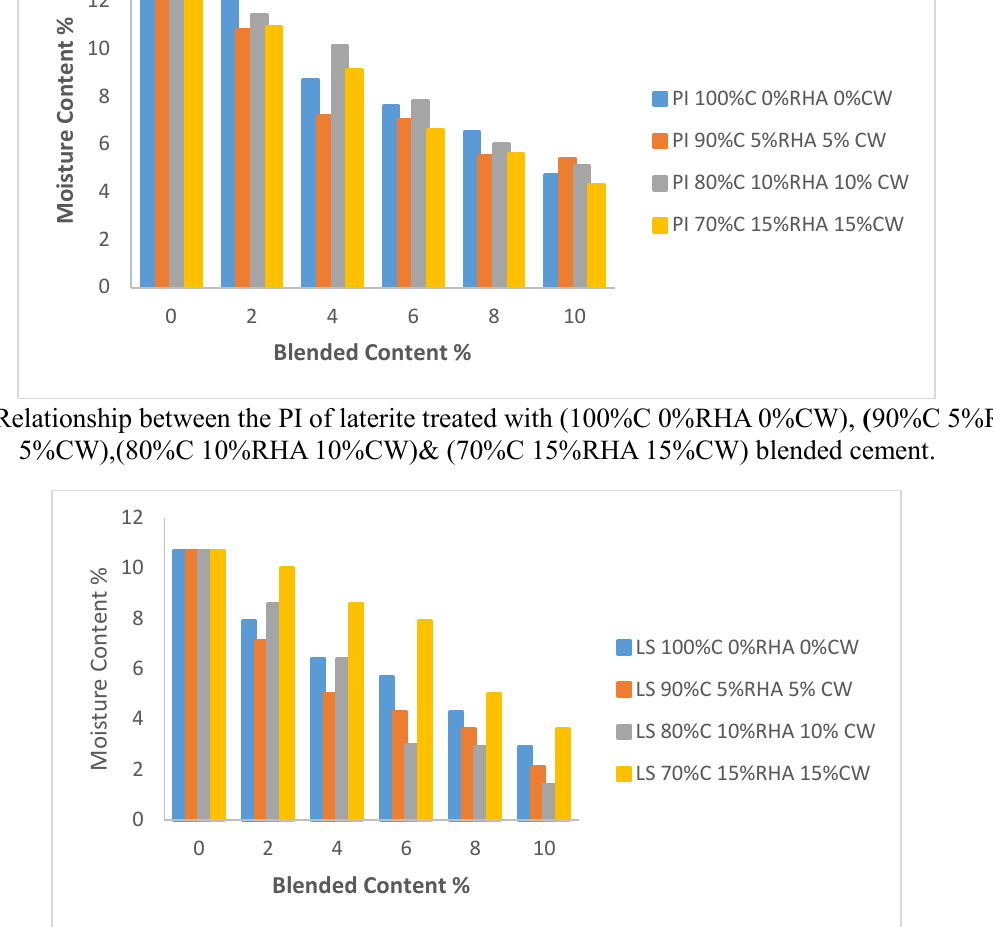
Fig. 5. Relationship between the LS of laterite treated with (100%C 0%RHA 0%CW), ( 90%C 5%RHA 5%CW),(80%C 10%RHA 10%CW)& (70%C 15%RHA 15%CW) blended